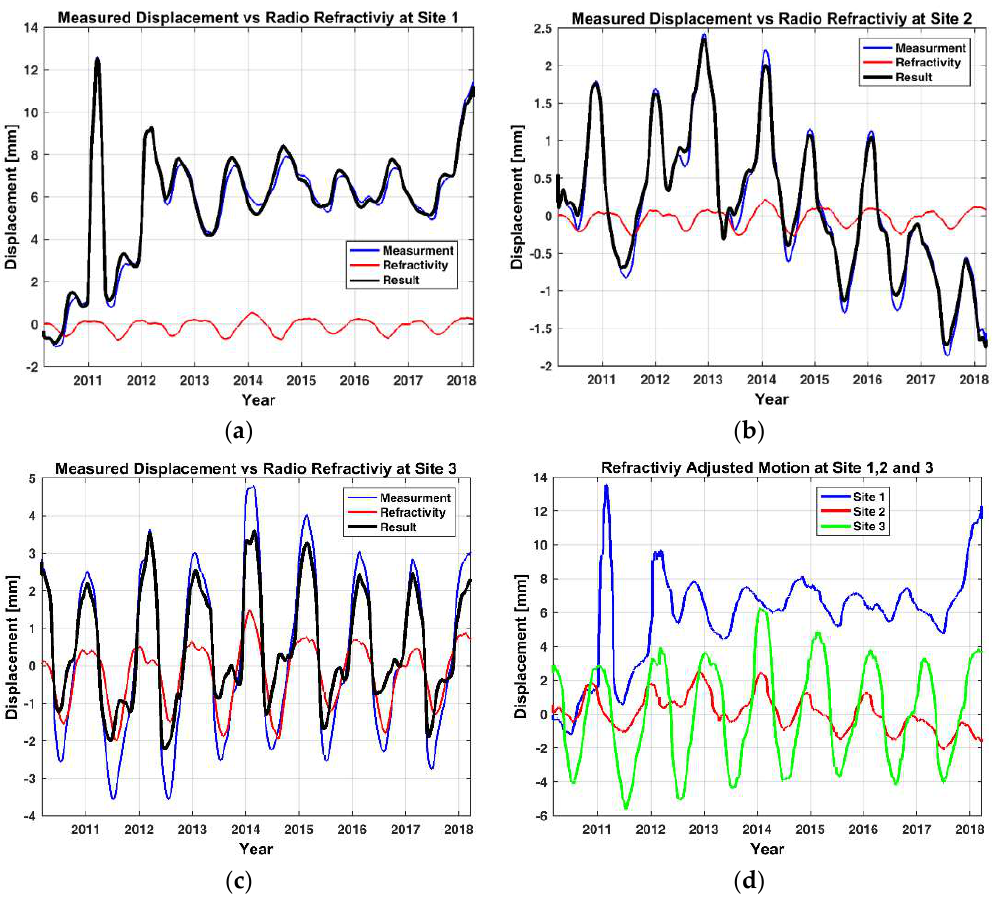
Figure 18. Three months moving average of the measured displacement adjusted with radio refractivity estimated from the meteorological data. ( a ) is Site 1, ( b ) is Site 2, ( c ) is Site 3, and ( d ) is all three sites combined. The blue line is the differential interferometric displacement. The red line is the variation in path length estimated from radio refractivity. The black line is the radio refractivity-corrected displacement. This shows that meteorological data can be used to reduce the path length variation due to variations in radio refractivity, in the case of Site 3 by approximately 35%. Note the different scaling of the y-axis on the four figures.